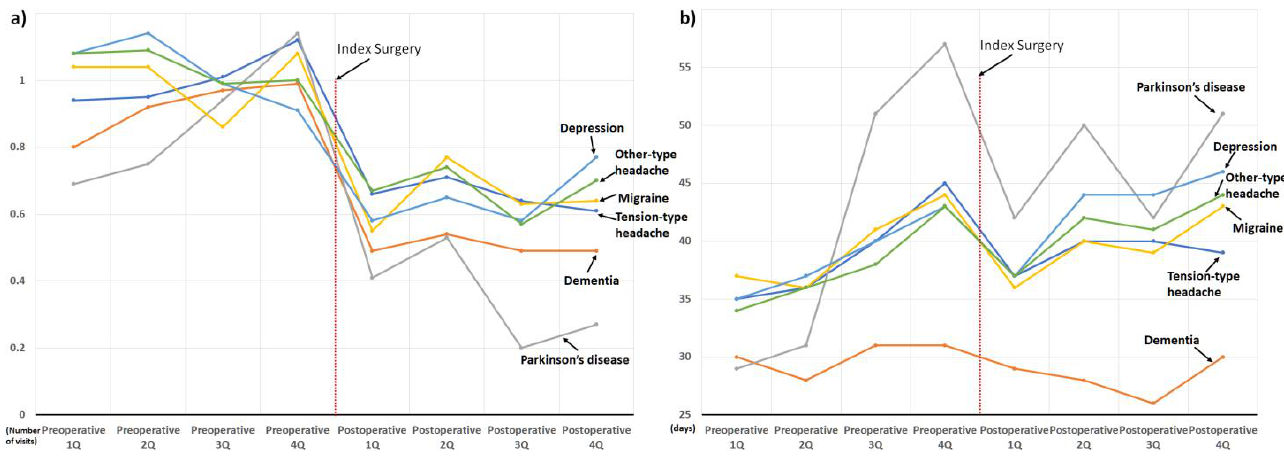
Figure 8. Perioperative changes in the use of sleep medication and hospital visits owing to sleep disorder according to the neuropsychiatric disorders: ( a ) changes in the number of hospital visits, and ( b ) changes in the prescribed duration of sleep medication.